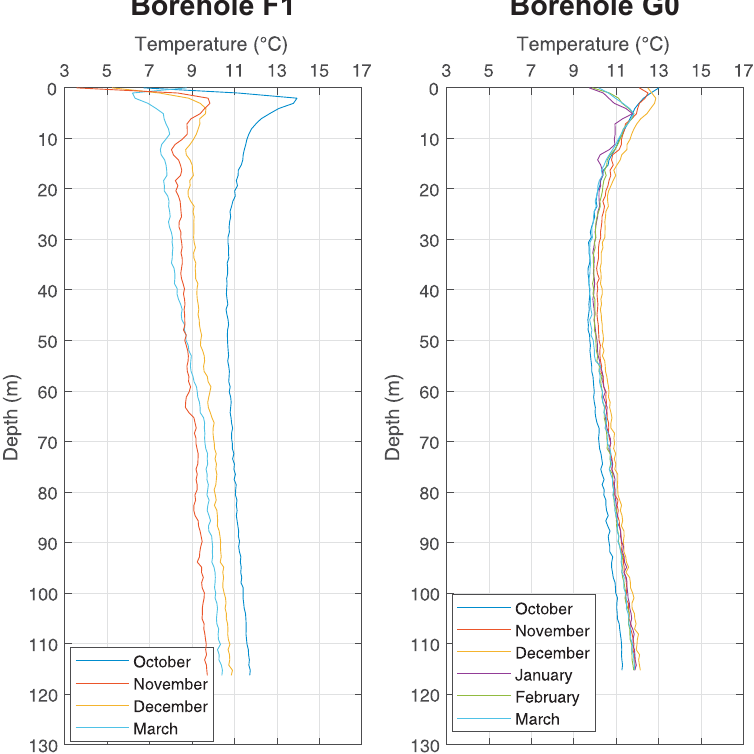
Figure 8. Graph of temperature changes with the depth at chosen monitoring borehole F1 and G0 of the Small Research Polygon